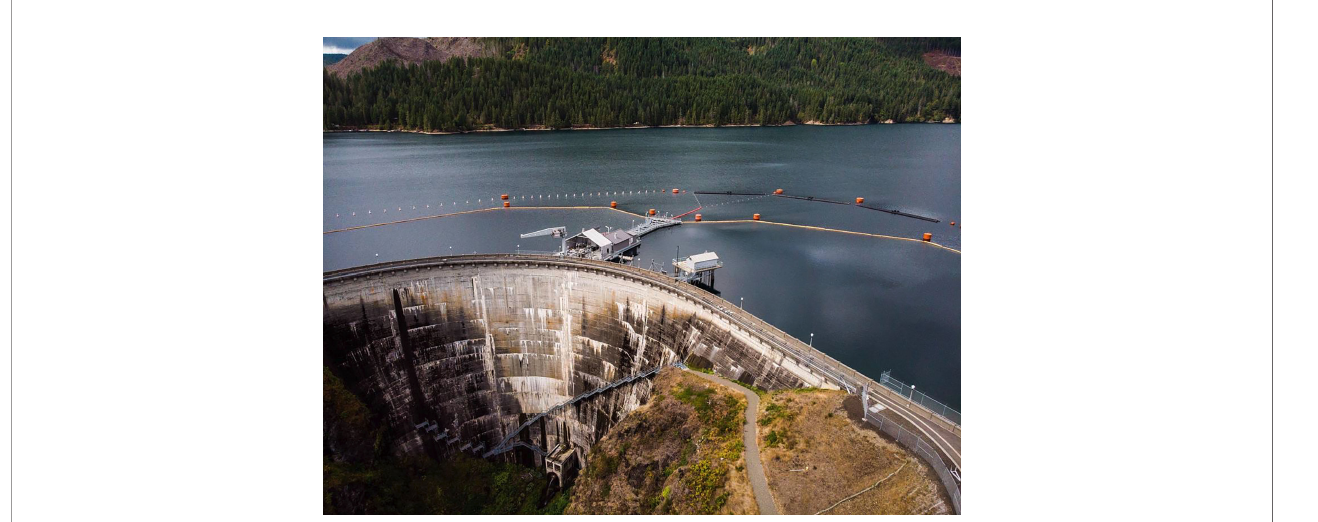
FIGURE 5 | Cushman Dam Number 1 (Source: Tacoma News Tribune, 2022).